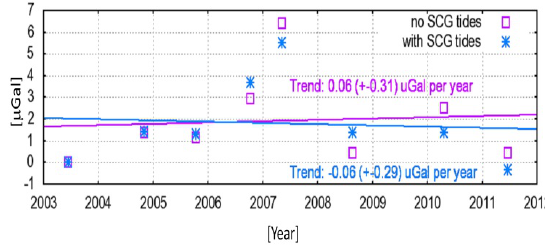
Figure 6: Gravity results before applying tides from GWR#54 (just synthetic tides) and the improved results with observational